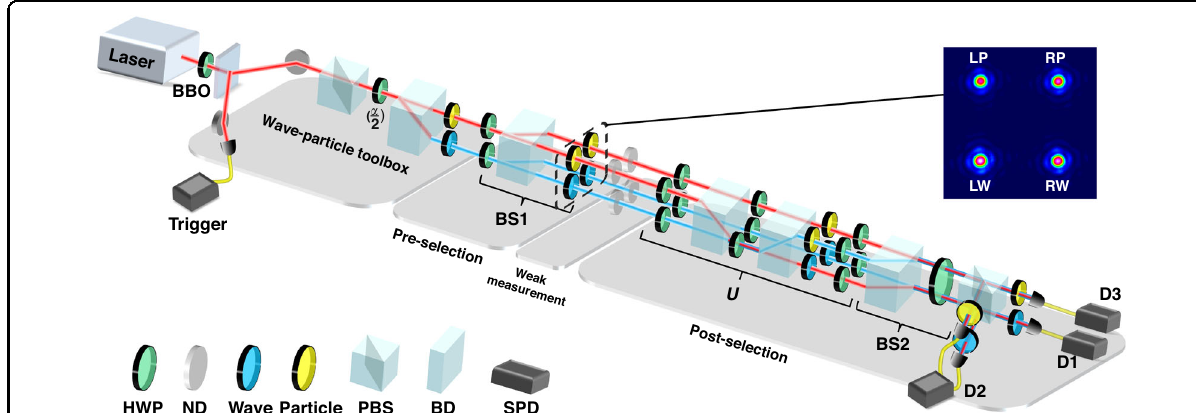
Fig. 2 Experimental setup for the separation of the wave and particle attributes. Wave ‒ particle toolbox: a single photon generated through spontaneous parametric down-conversion enters the wave ‒ particle toolbox. The fi rst half-wave plate (HWP) after the polarization beam splitter (PBS) controls the proportion of the horizontal and vertical polarization states ( H j i and V j i , respectively), namely the initial state, ψ 0 A beam displacer (BD) is exploited to divide the beam into the up path (red) encoding the particle attribute and the down path (blue) encoding the wave attribute. The blue and yellow plates comprising a set of plates (HWP and quarter-wave plate) are used to prepare the wave attribute state and particle attribute state, respectively. Pre-selection: The input state is injected into BS1, and the pre-selection state is obtained. Weak measurement: Neutral density (ND) fi lters with different transmission rates are inserted into the corresponding path to simulate the weak disturbance. Post selection: The corresponding evolution operation U is only carried out on the right paths. Single-photon detectors (SPD; D1 – D3) are used to detect the